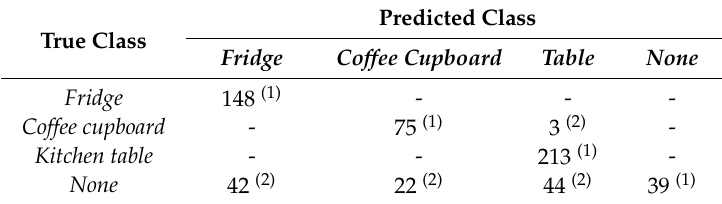
Table 9. Confusion matrix created from the proximity detections.